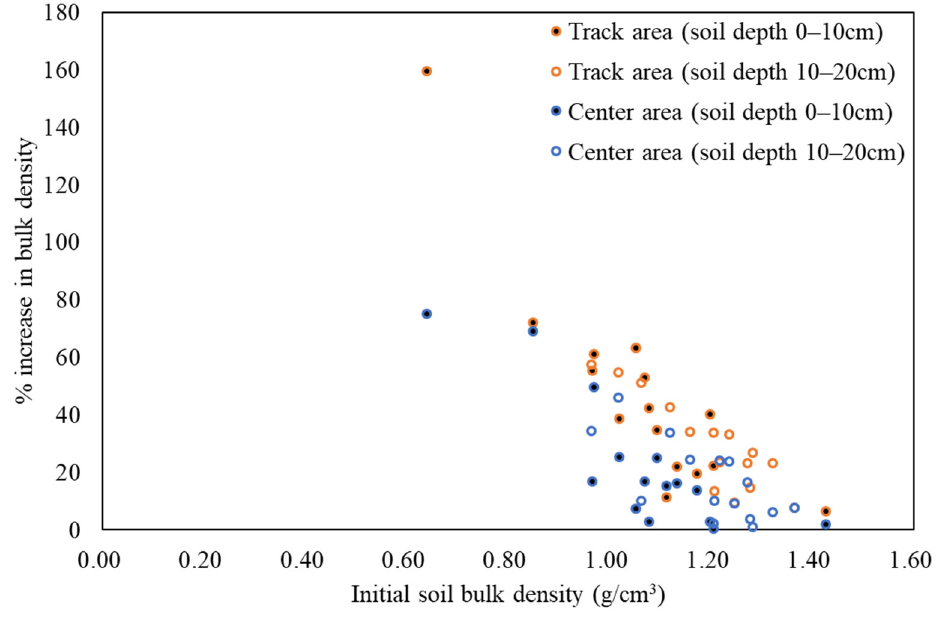
Figure 6. The correlation between initial soil bulk density and percent increase in bulk density in forwarding trail.